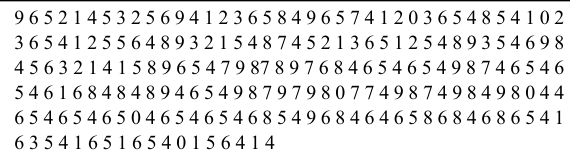
Table 2 - Fragment of the “Bourdon test”.